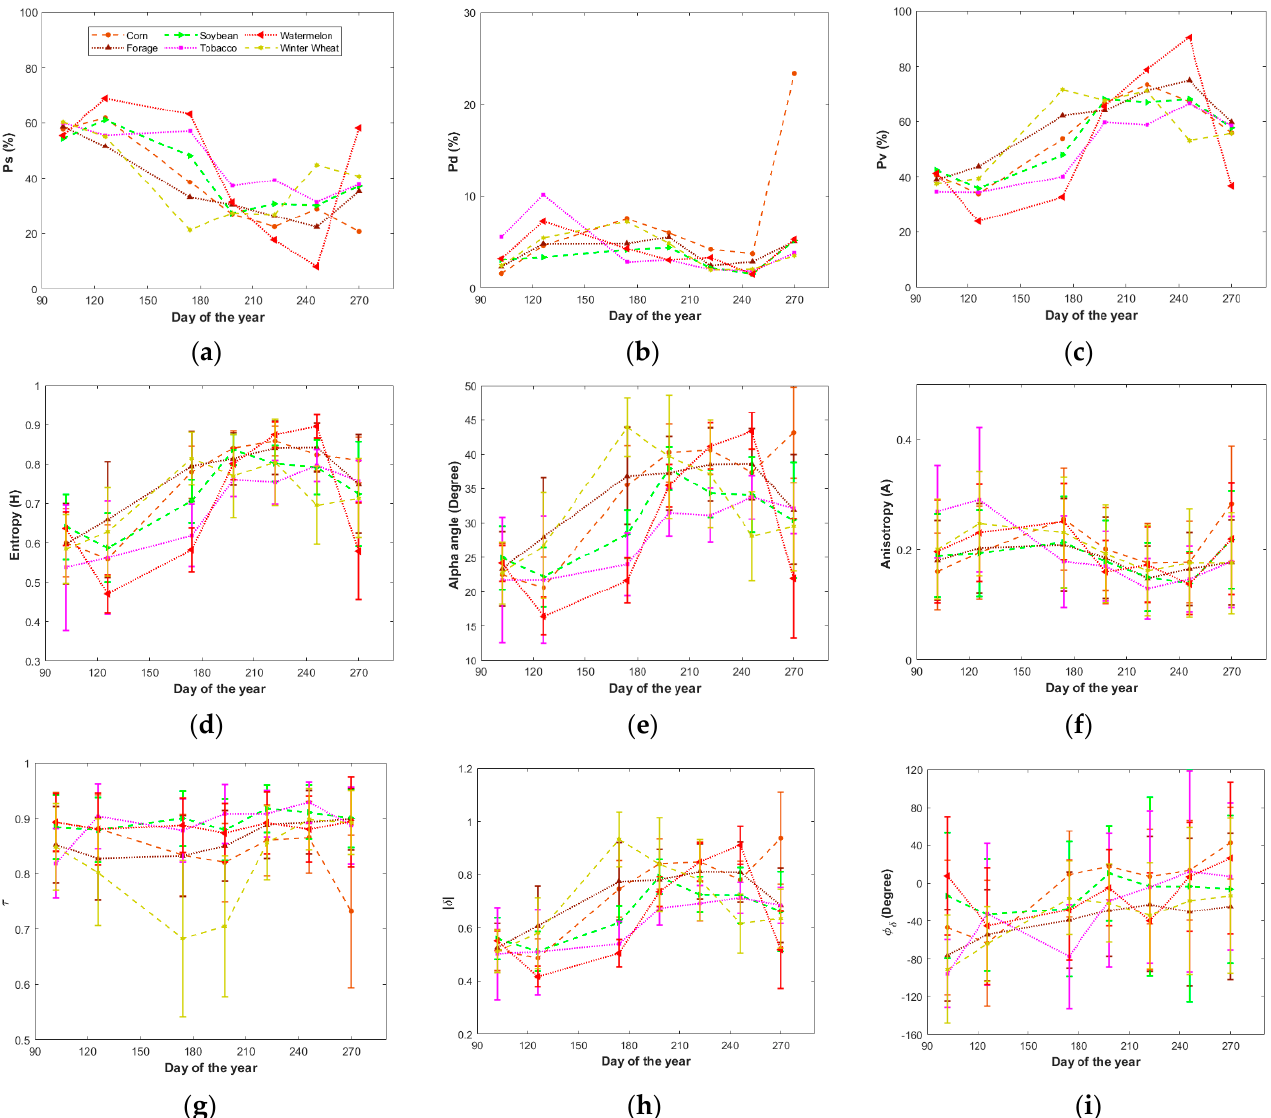
Figure 6. Temporal evolutions of polarimetric decomposition parameters for different crops. ( a ) surface scattering (Ps); ( b ) double-bounce scattering (Pd); ( c ) volume scattering (Pv); ( d ) entropy (H); ( e ) alpha angle ( α ); ( f ) anisotropy (A); ( g ) degree of orientation randomness ( τ ); ( h ) magnitude of the particle scattering anisotropy |𝛿| ; ( i ) phase of the particle scattering anisotropy 𝜙 (cid:3083) . Note error bars denote standard deviation.